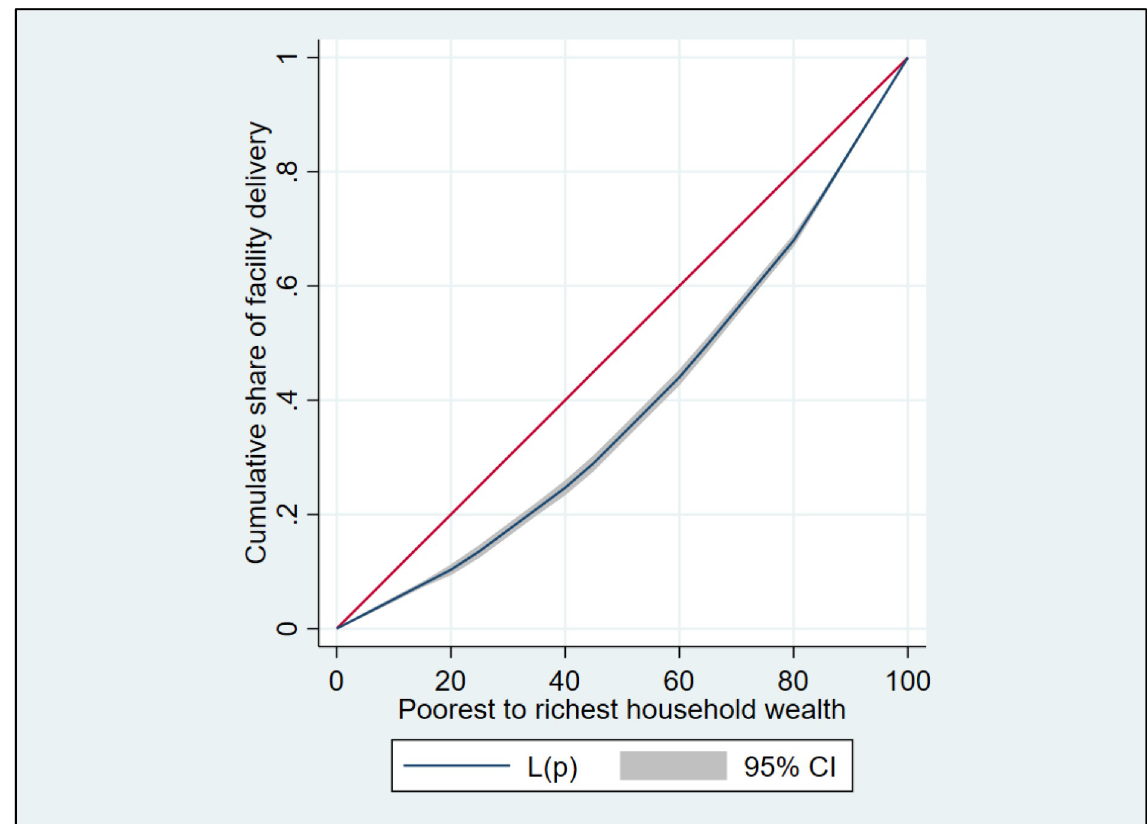
Fig 2. Concentration curve for facility delivery against household wealth